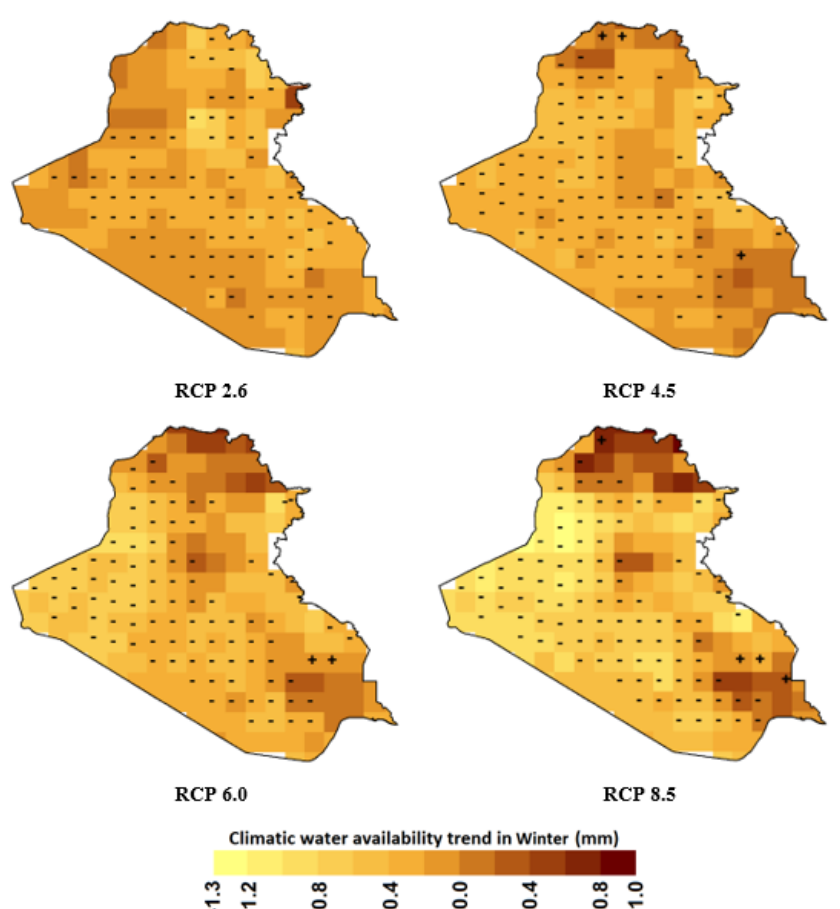
Figure 6. Spatial variations of winter CWA trends for different RCPs during 2010–2099, the sign (+ or − ) specifies an increase or decrease in CWA estimated by the mMK test at p = 0.05. A decreasing winter CWA at p = 0.05 was noticed in most of the regions for all the RCPs. The decrease was highest in central Iraq by − 0.8 to − 1.3 mm/year and the lowest in the northern steppes and the southern coast by − 0.1 to − 0.4 mm/year for all the RCPs. The winter CWA was also noticed to increase at a few grids in the far south and in the north for RCPs 6.0 and 8.5 by 0.8–1.0